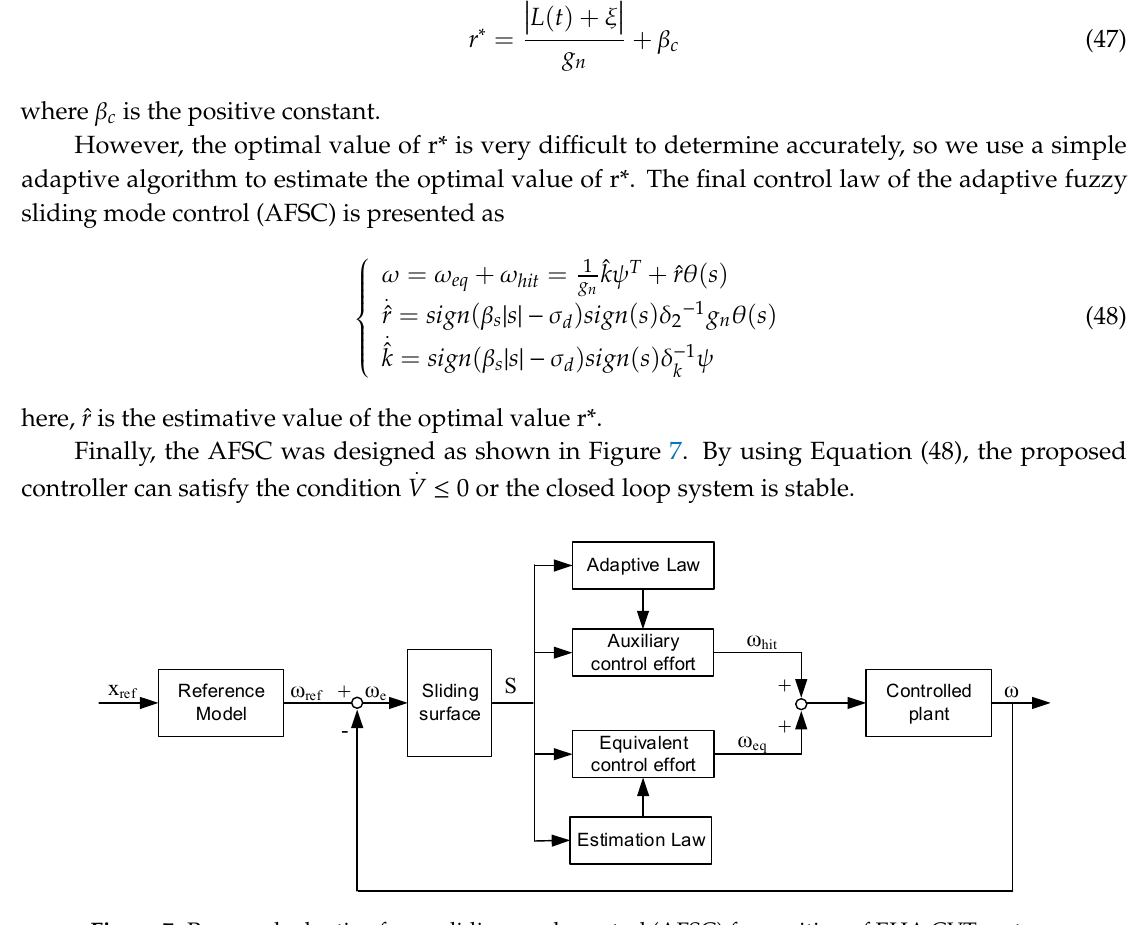
Figure 7. Proposed adaptive fuzzy sliding mode control (AFSC) for position of EHA CVT system